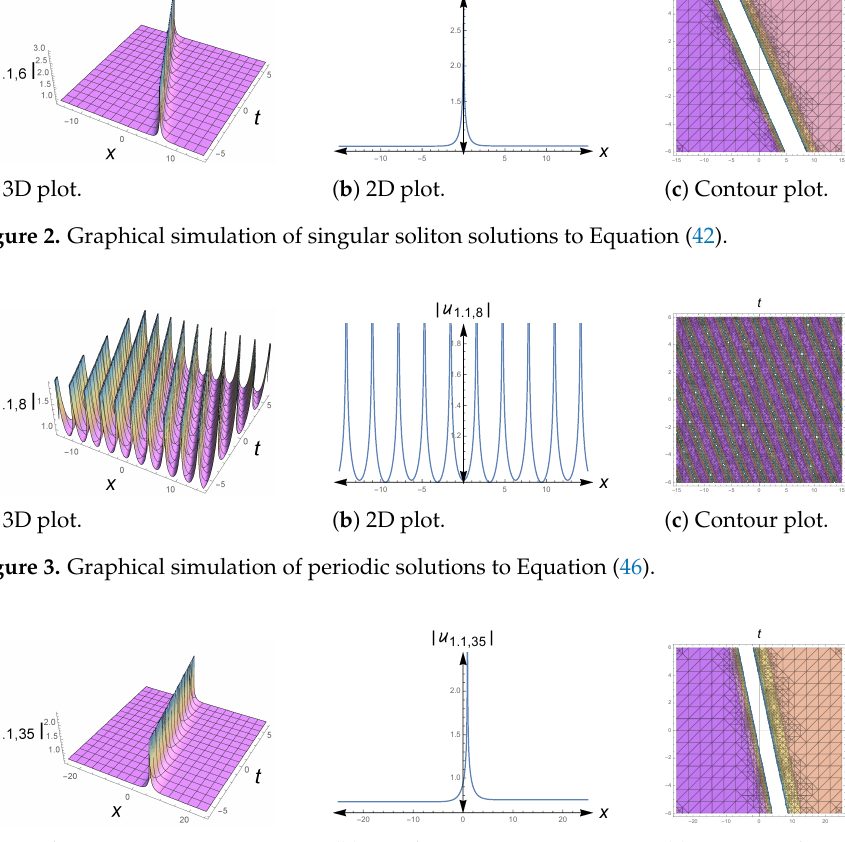
( a ) 3D plot. ( b ) 2D plot. ( c ) Contour plot. Figure 4. Graphical simulation of singular combo soliton solutions to Equation (100).